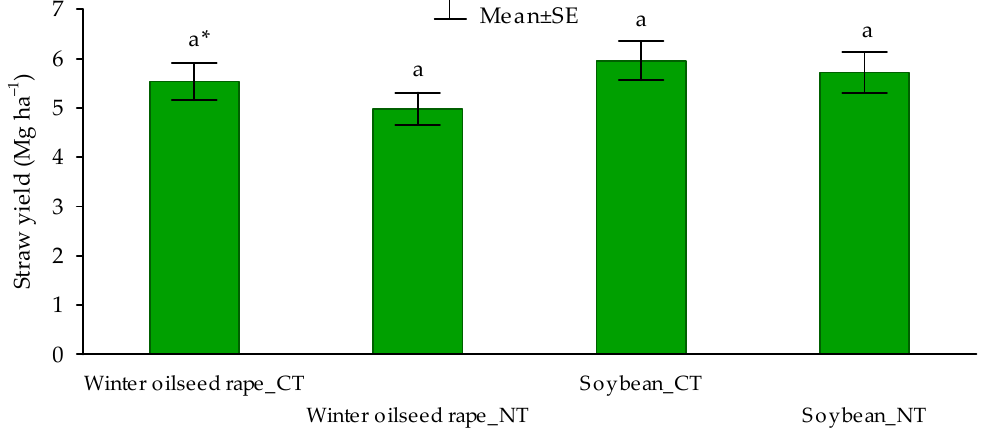
Figure 4. Interactive dependencies of previous crop and tillage system in determining winter wheat straw yield (mean for 2014–2017). CT—Conventional tillage; NT—No-tillage. * The same letter means not significantly different values ( p ≤